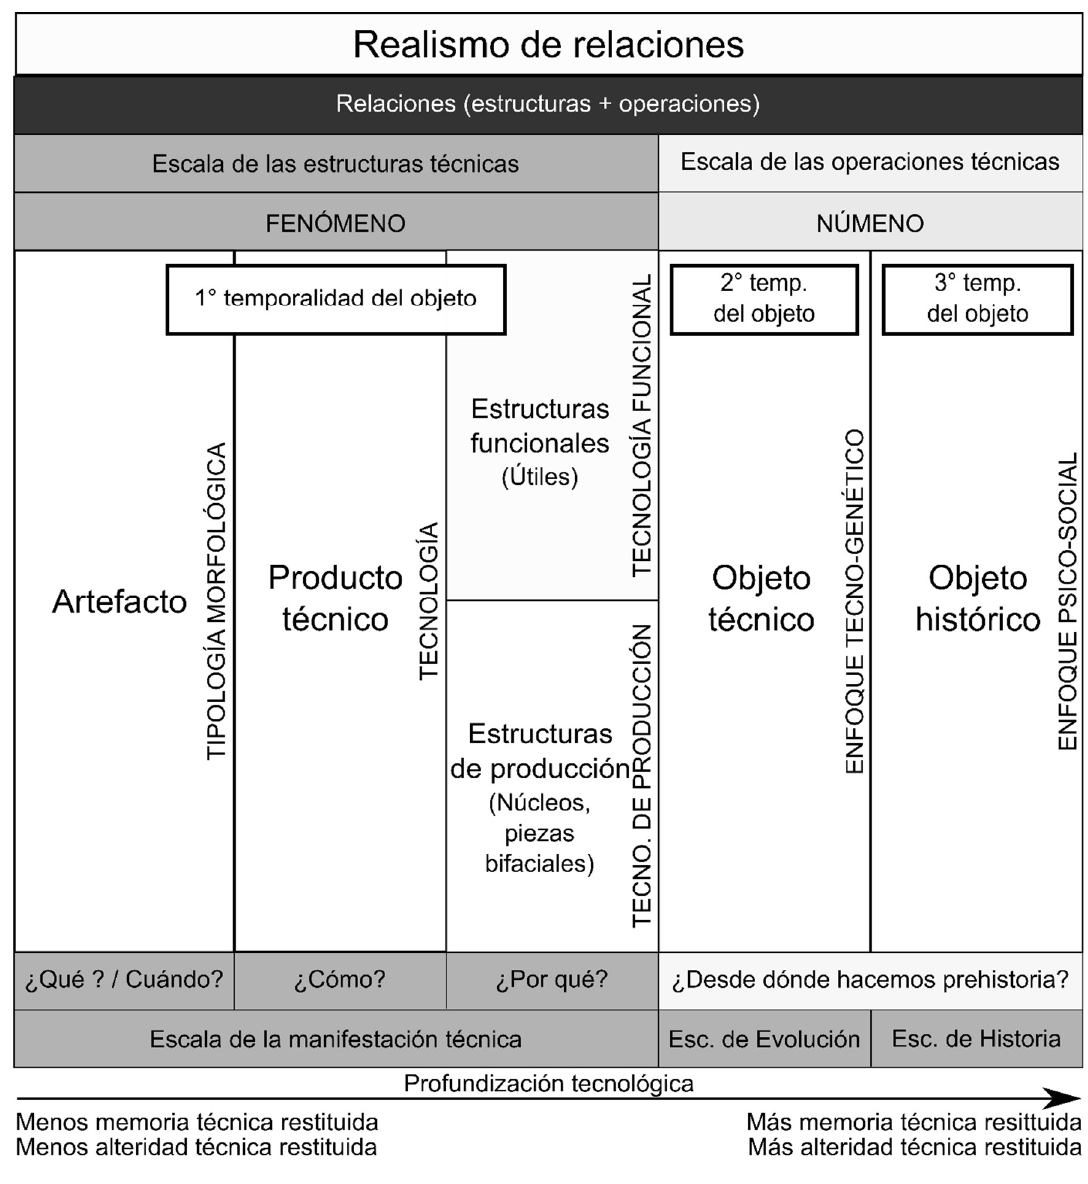
Figura 3. Diagrama categorial en tecnología prehistórica basado en la epistemnología del realismo de